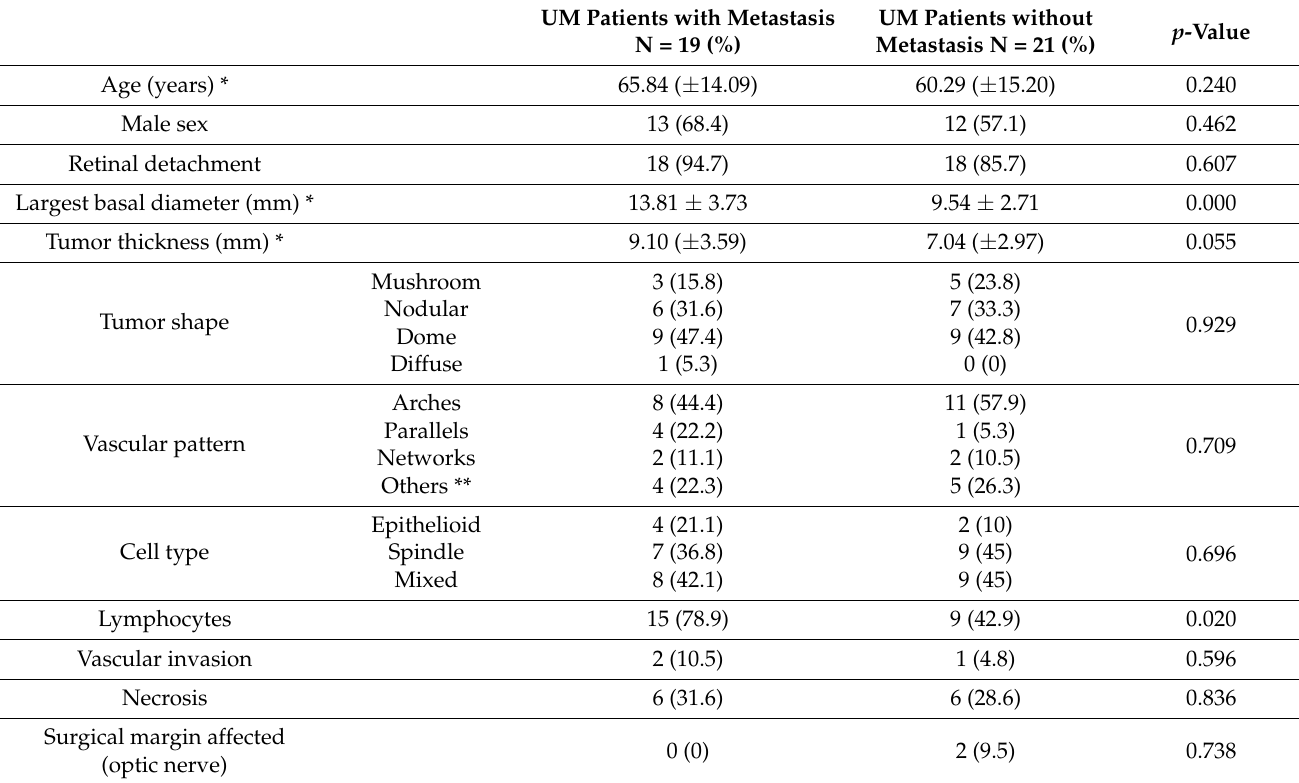
Table 1. Clinicopathological features of enucleated eyeballs with or without metastasis. UM Patients with